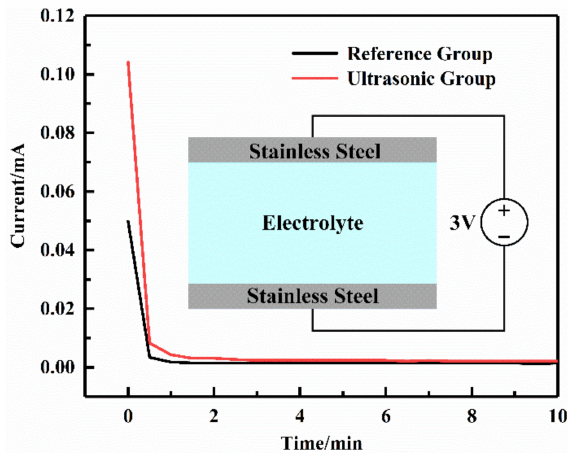
Figure 4. DC polarization test curves of solid polymer